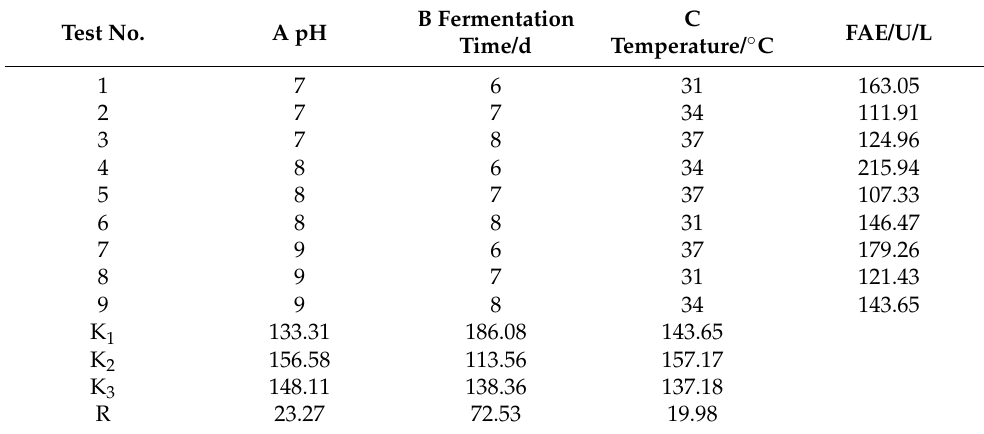
Table 2. The results of the orthogonal